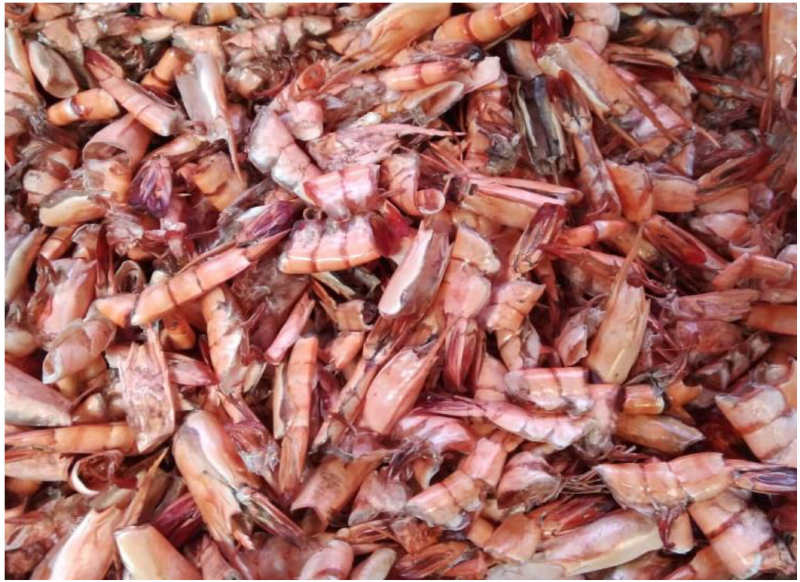
Figure 1. Dry carapace of M. rosenbergii